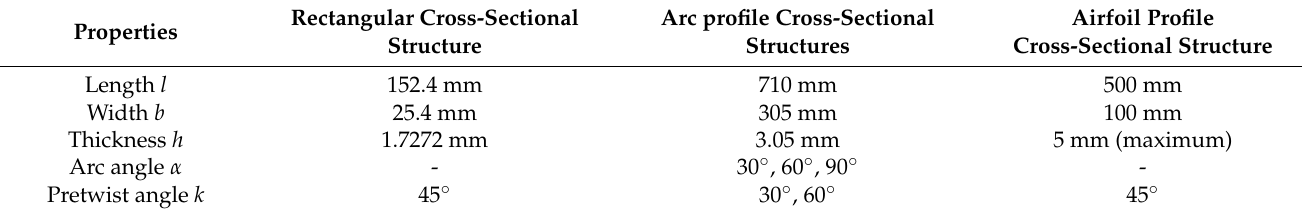
Figure 4. Geometries of a pre-twisted structure with airfoil profile cross section. Table 1. Physical properties of pre-twisted structures.